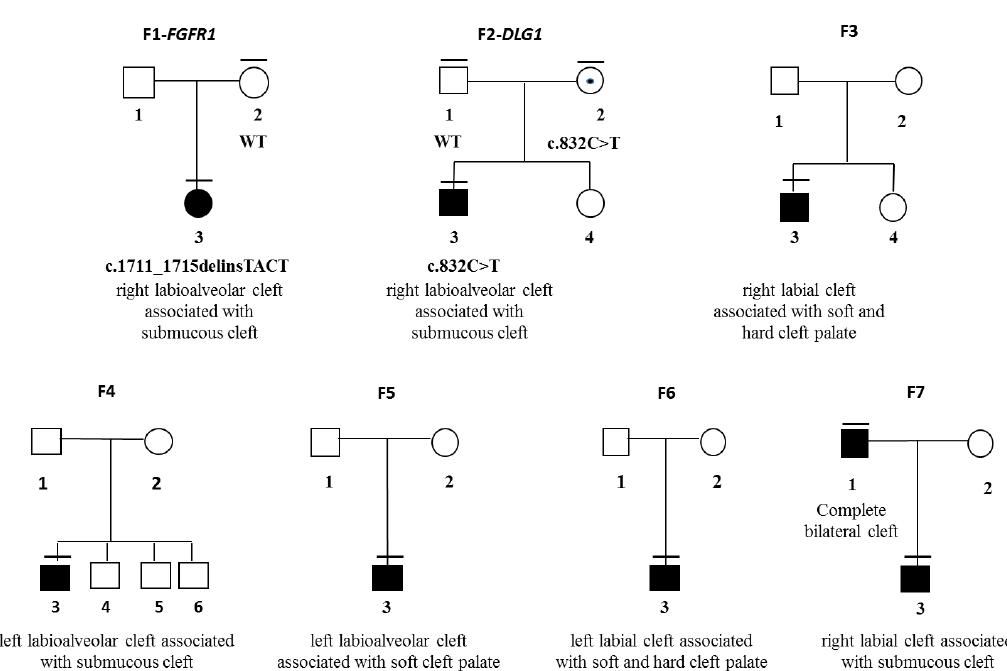
Figure 2. Pedigrees of discontinuous CLP patients. Family number and gene marked above the pedigree (F-#-gene). Gender symbol with a central dot indicates carriers. Variant given underneath each carrier/affected. Clinically studied individuals have a horizontal bar over the top. The CLP phenotype is described in detail.